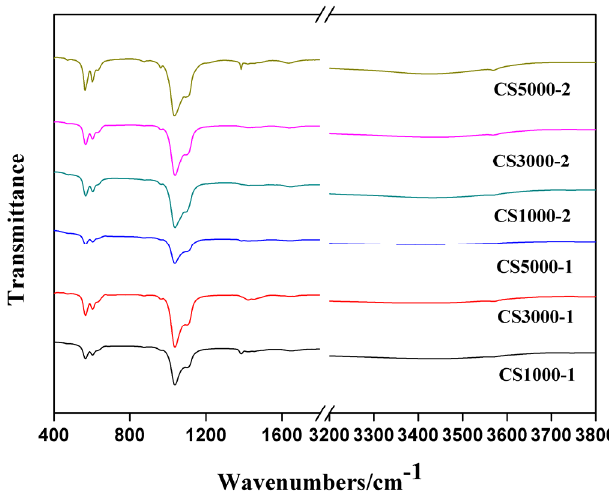
Figure 1. FTIR spectra of HA samples synthesized under different conditions.